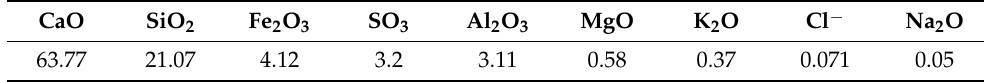
Table 1. Chemical composition of Portland cement [wt.%].